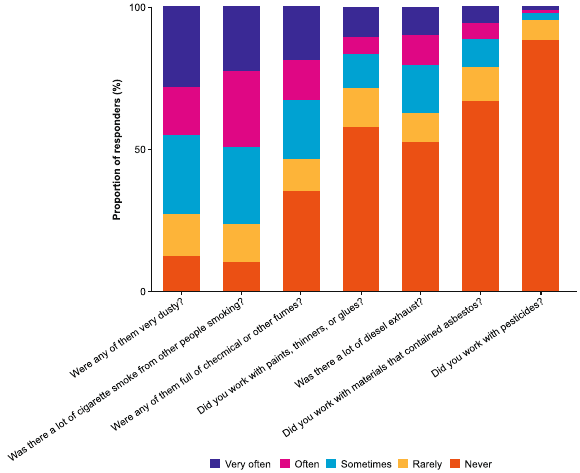
Fig. 3 Self-reported working environments for participants with COPD in the Ext-SLS who reported working outside the home. COPD chronic obstructive pulmonary disease, Ext-SLS Extended Salford Lung Study. Note: Responders n = 337 – 346 variable per